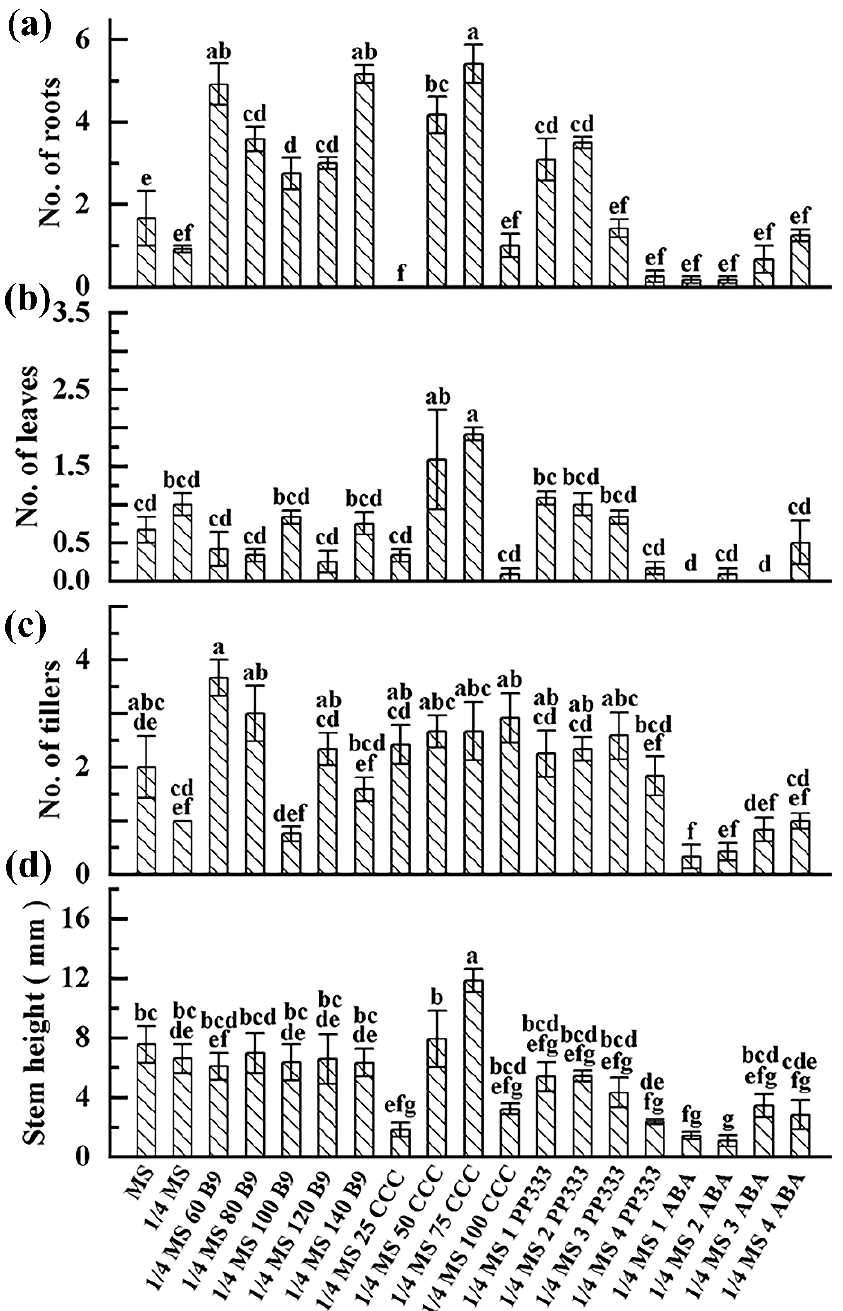
Figure 5. Growth statues of G-2 plantlets incubated in slow-growth media. Data were surveyed 60 d post-culture. ¼ MS 60 B9 refers to ¼ MS medium supplemented with 60 mg/L B9, and so on. ( a – d ): Average plant height, number of new leaves, number of new tillers, and number of new roots of ginger G-2, respectively. Data are presented as means ± SE. Significant differences were analyzed as one-way ANOVA at p <